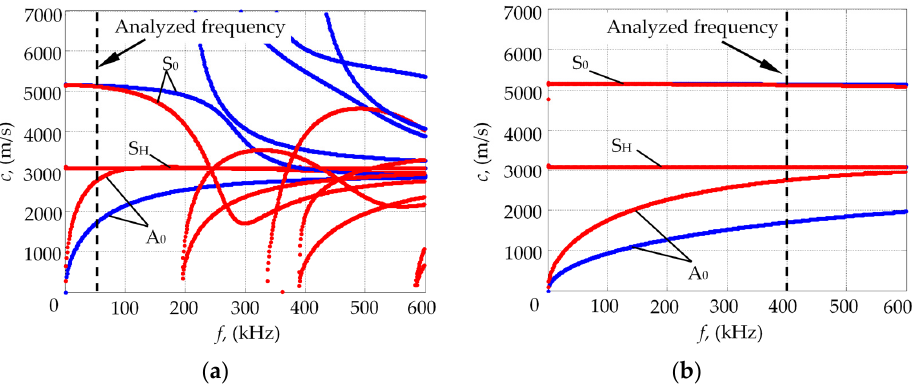
Figure 1. Ultrasonic guided waves phase (blue) and group (red) velocities dispersion curves for: ( a ) 8 mm thickness stainless steel plate; ( b ) 1 mm thickness stainless steel plate. Table 1. Velocity of the asymmetric A 0 , symmetric S 0 , and shear horizontal S H guided waves modes at 400 kHz frequency for 1 mm thickness stainless steel plate. Guided Wave Mode Phase Velocity c ph , m/s Group Velocity c gr , m/s Asymmetric A 0 1701 2751 Symmetric S 0 5156 Shear horizontal S H 3106